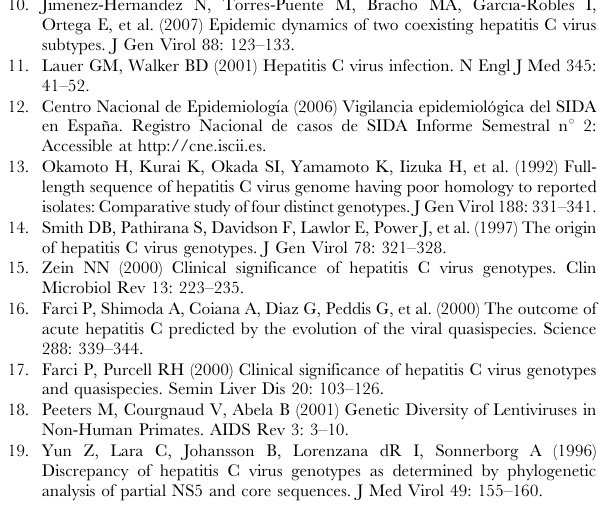
Table S2 Summary of SH and ELW tests for alternative topologies derived from the recombination events detected